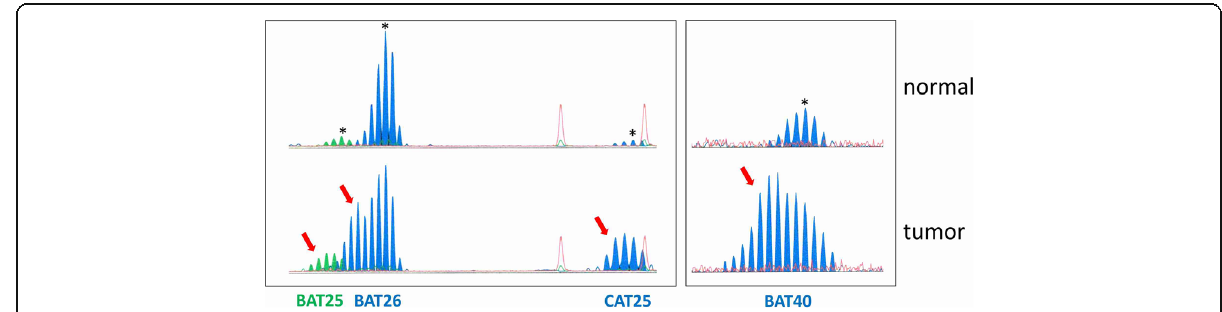
Fig. 1 Results of microsatellite instability analysis. Peak patterns of the MSI tumor analyzed by the GeneMapper Software (version 5, Applied Biosystems) show aberrant peak profiles indicative of MSI in all 4 tested mononucleotide markers. Highest peaks in MSI profiles obtained from normal tissue are marked by asterisks (upper panel). Aberrant peaks detected in tumor tissue are marked by red arrows (lower